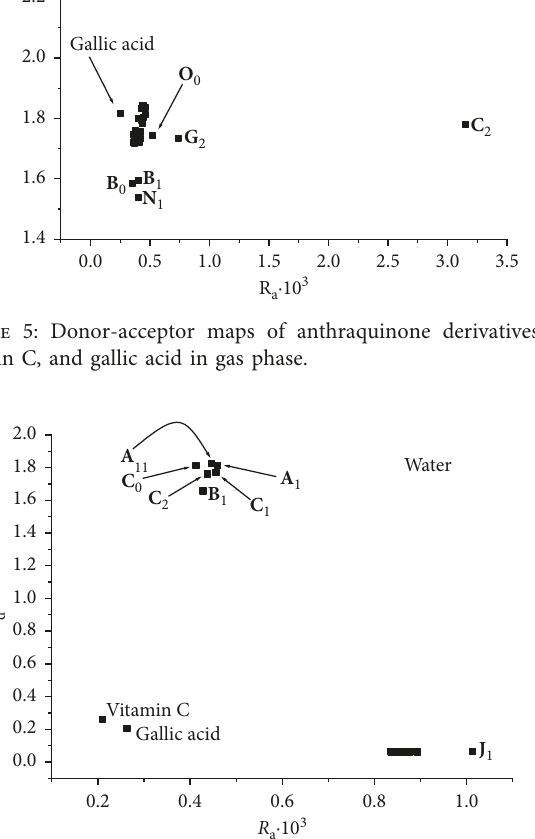
Table 5: Ionization potential (eV), electron affinity (eV), elec- trodonating power ( ω − ) and electroaccepting power ( ω + ), donor index ( R d ), and acceptor index ( R a ) calculated at B3LYP/6- 311++G(d,p) in vacuum and